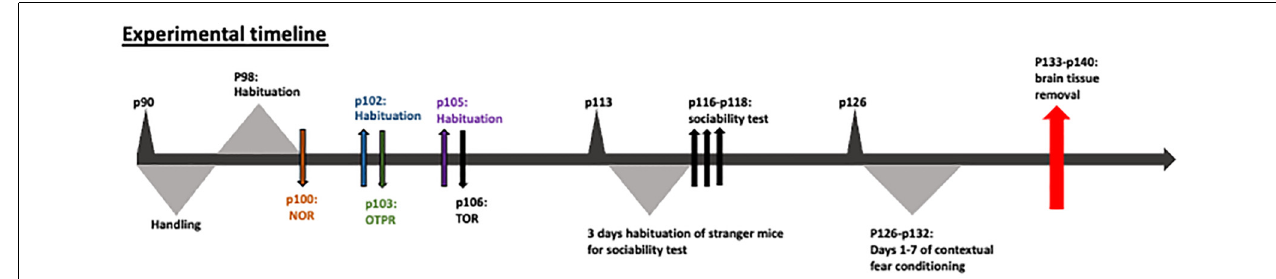
FIGURE 1 | Experimental